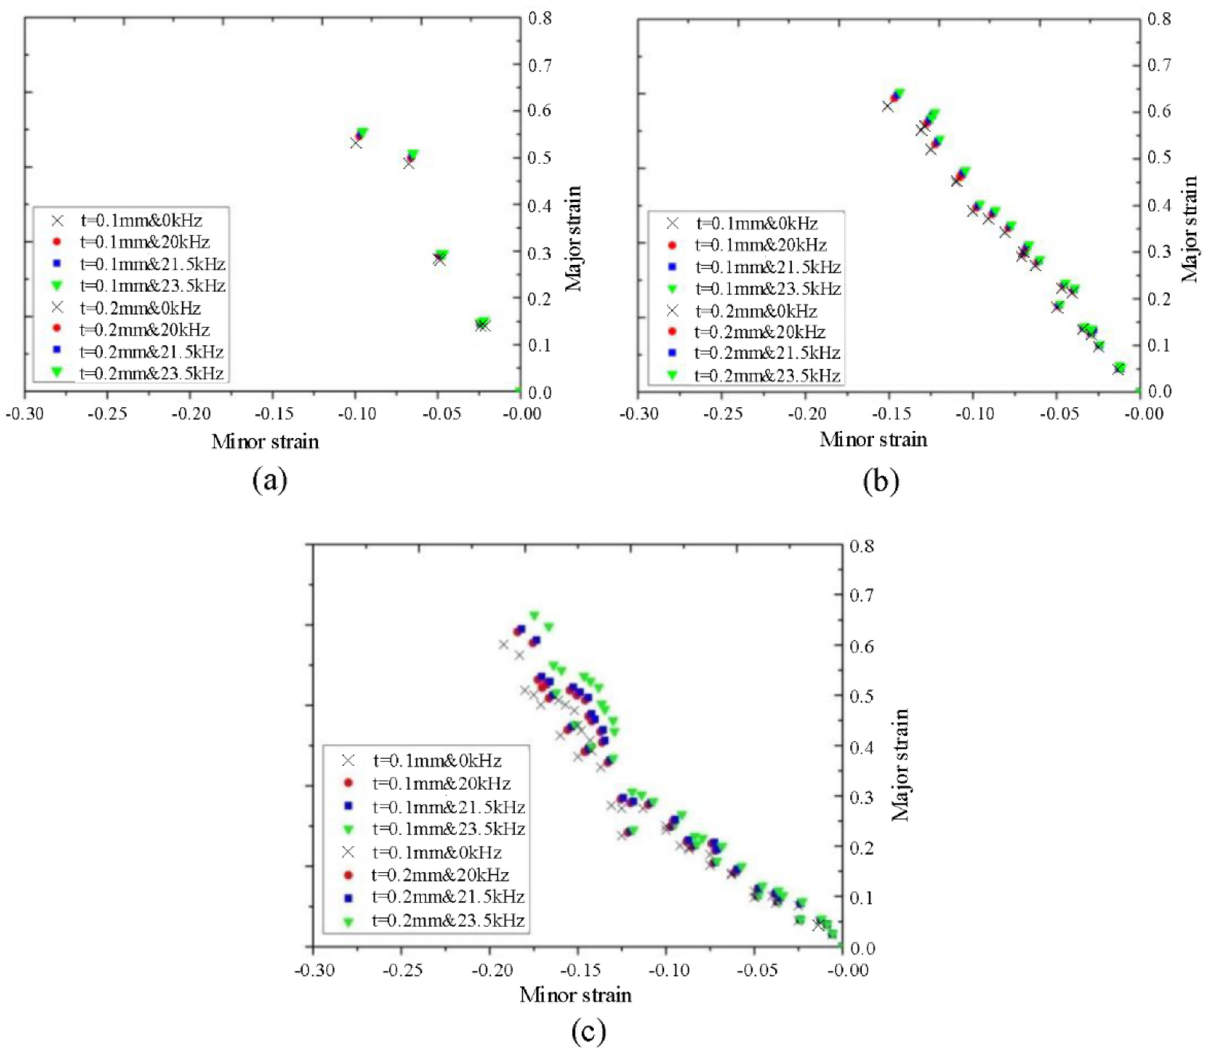
Fig. 5. Limit strain of different specimens under ultrasonic vibration. (a) spec1. (b) spec2. (c) spec3.